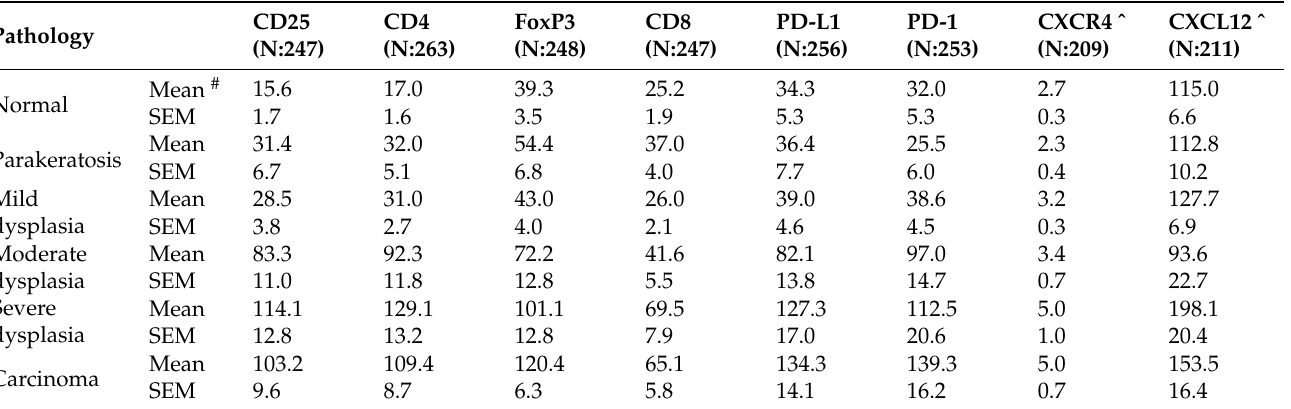
Table 3. T cell, checkpoint molecule and chemokine quantitation in oral potentially malignant and malignant lesions.